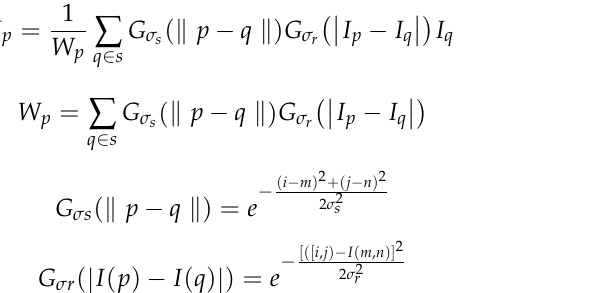
Figure 4. Schematic of the 3rd algorithm.